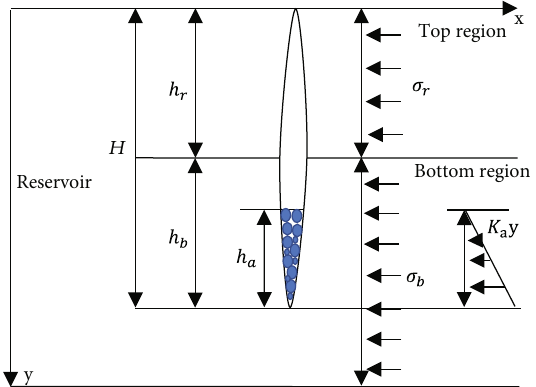
Figure 5: Stress distribution on fracture surface with arti fi cial